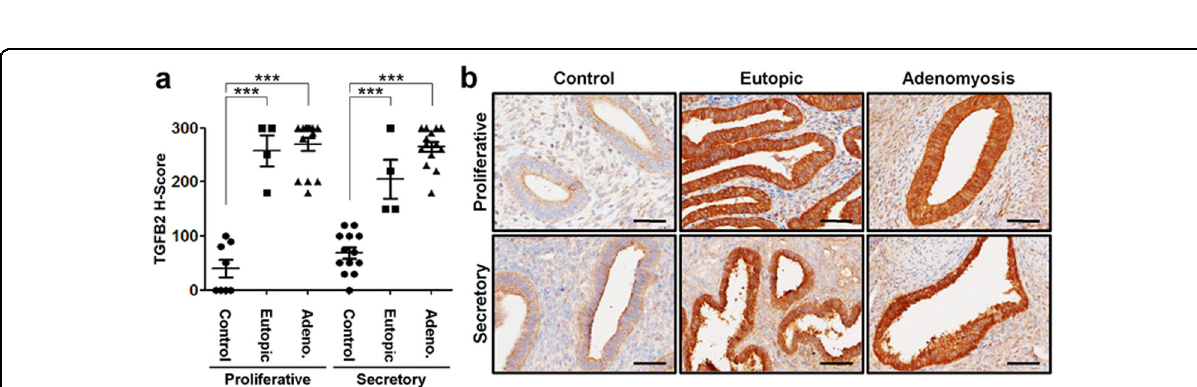
Fig. 2 The expression of TGF- β 2 and E-cadherin in the mutant mouse uterus. Immuno fl uorescence analysis of TGF- β 2 and E-cadherin ( a ) or vimentin ( b ) in the uteri of control and mutant mice at 4 weeks of age ( n = 5 per genotype). Nuclei were counterstained with DAPI. Arrowheads indicate TGF- β 2- and vimentin-positive epithelial cells. Scale bars represent 50 μ m.